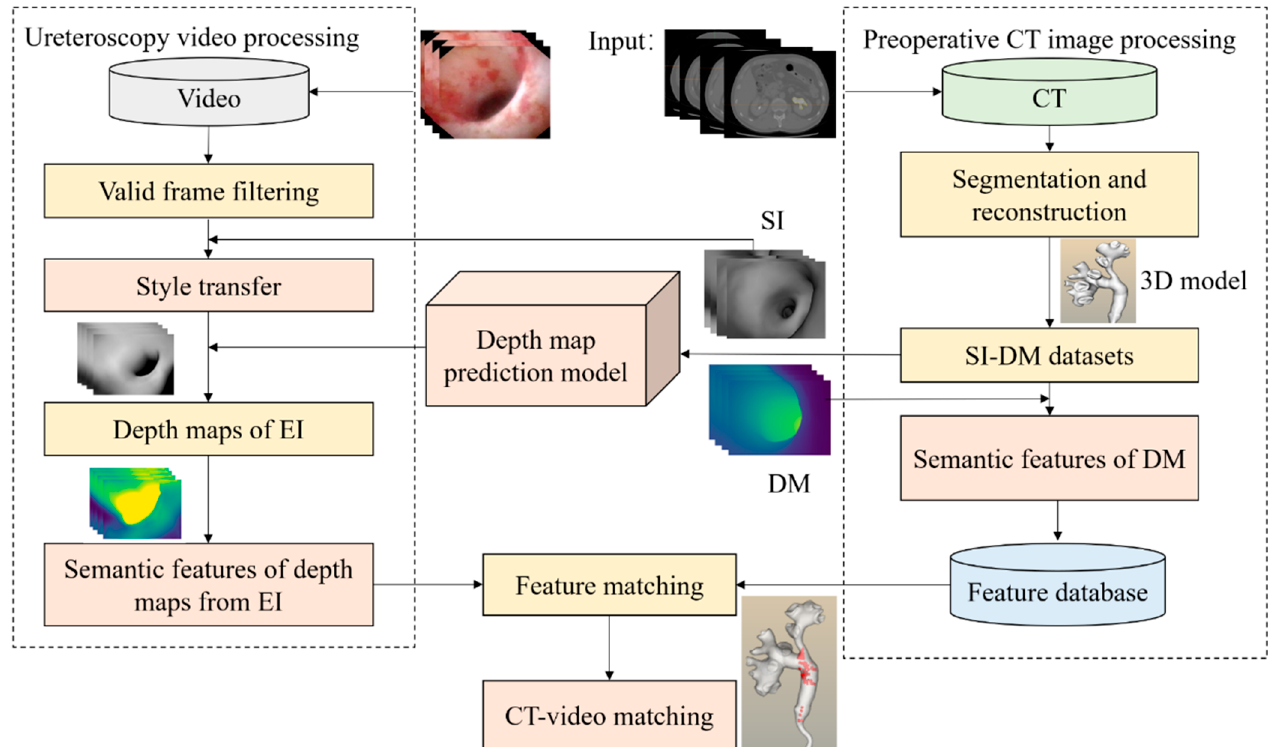
Figure 1. Flowchart of our proposed method.